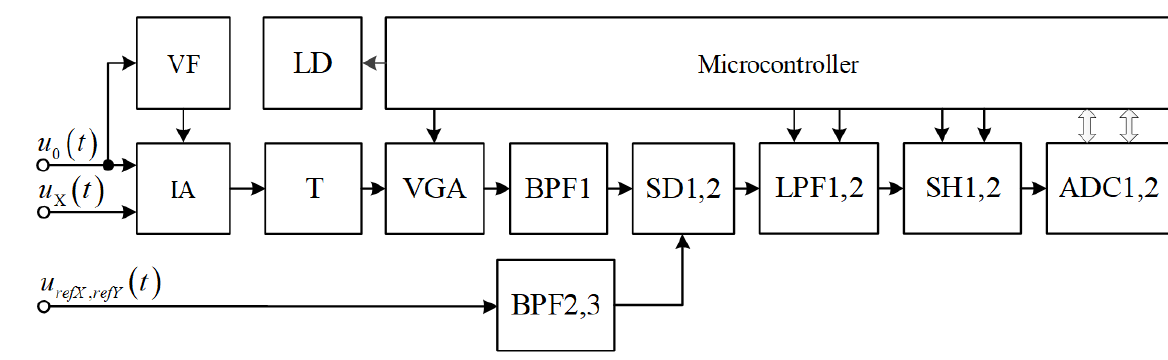
Figure 8. Flowchart of the dual phase analog lock-in amplifier.